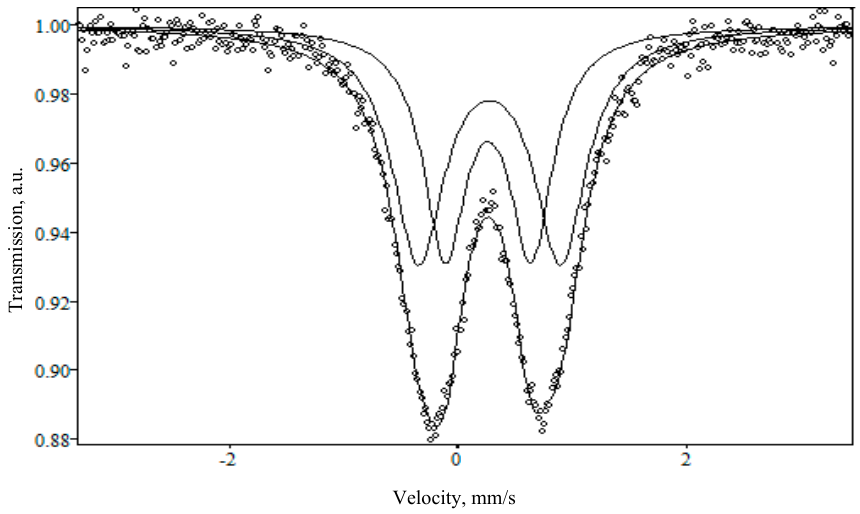
Figure 4. Mössbauer spectrum of the LiFeSi sample obtained at room temperature and in an external magnetic field. Table 1. Hyperfine parameters obtained from Mössbauer spectrum of the NaFeSi and LiFeSi samples.